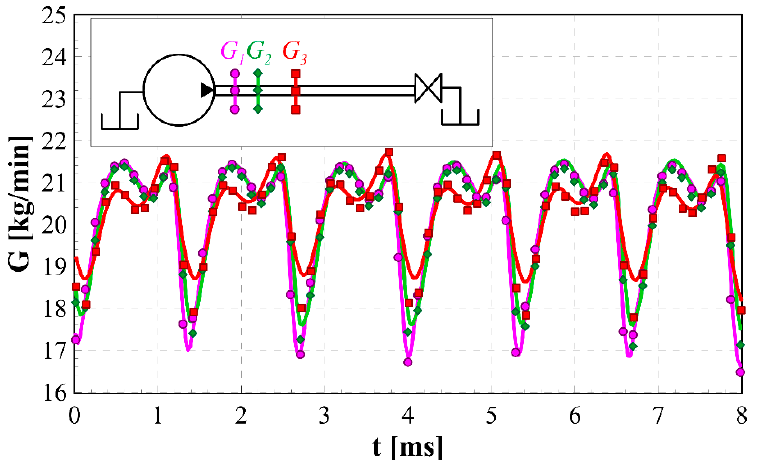
Figure 16. Comparison between the simulated flowrates (symbols) and the ones obtained based on Equation (4) algorithm (continuous line) at different pipe cross-section areas at 3500